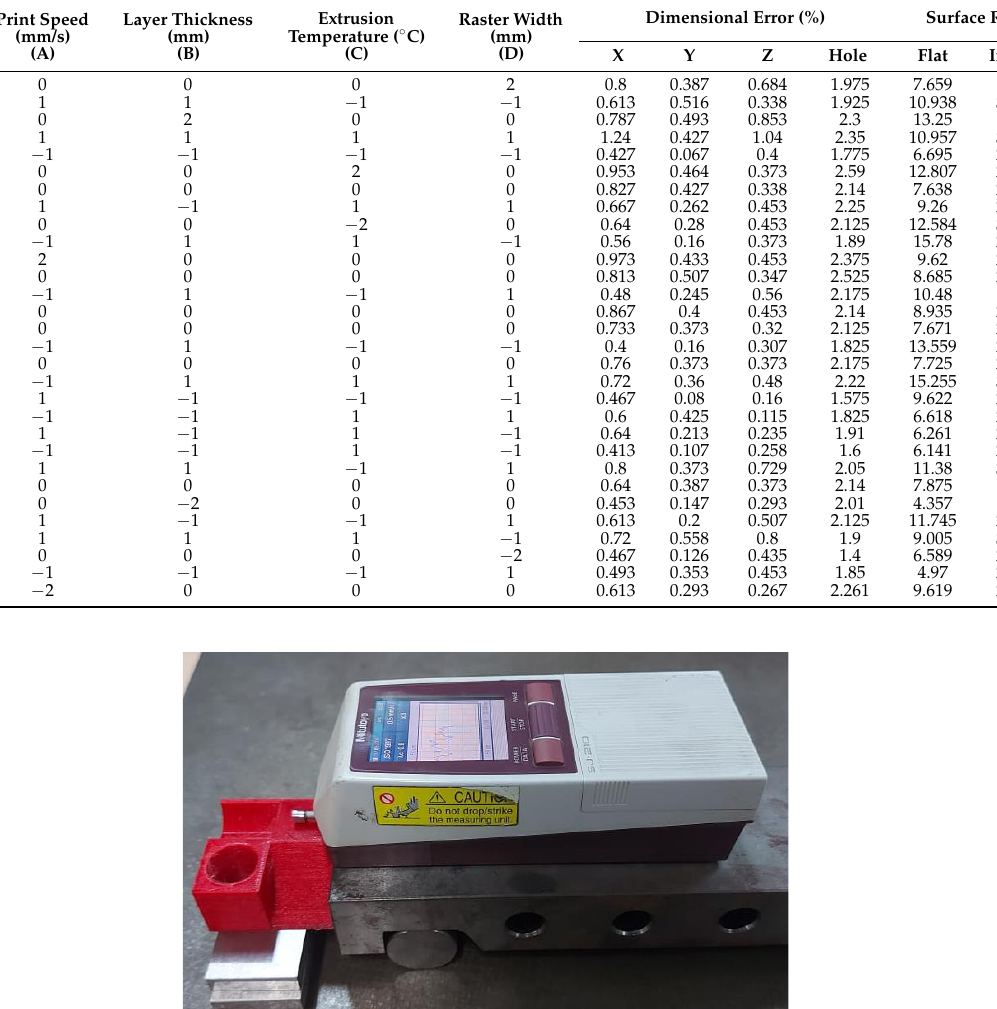
Figure 4. Surface roughness report generated by SURFTEST SJ-210 for run 12. 2.2. Statistical Modelling of Experimental Data Response surface methodology (RSM) was used to develop statistical models for dif- ferent output parameters owing to its better predictive performance for low order non- linear processes with a regular experimental domain, as reported by Benyounis et al. [55]. The factor contributions derived from the coefficients in the RSM developed regression model allow for identifying the insignificant factors and interactions, thereby reducing the complexity of the problem. In this study, Design Expert v13 software was used to de- velop second order quadratic RSM models (shown in Equation (1)) on the input data given in Table 2 to estimate linear, interaction and quadratic effects of the input factors and to provide prediction models for response parameters. Let Q denote the predicted response value dependent on the four input parameters namely, print speed (A), layer thickness (B), extrusion temperature (C) and raster width (D). Then, Q can be written as